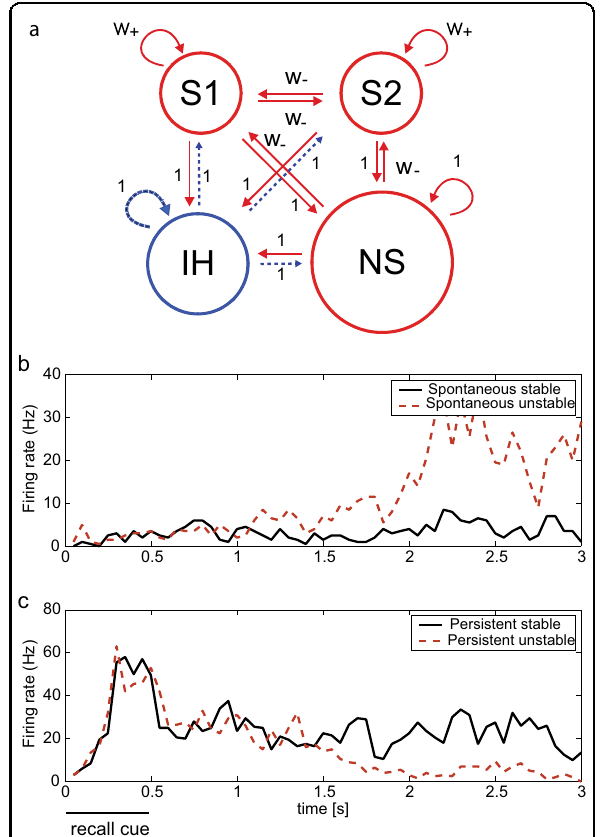
Fig. 2 Stability and Instability in Attractor Networks. a The attractor network model. The excitatory neurons (red) are divided into two selective pools S1 and S2 (with 40 neurons each) with strong intra-pool connection strengths w + and one non-selective pool (NS) (with 320 neurons). The other connection strengths are 1 or weak w − . The network contains 500 neurons, of which 400 are in the excitatory pools and 100 are in the inhibitory pool IH (blue). Each neuron in the network also receives inputs from 800 external neurons, and these neurons increase their fi ring rates to apply a stimulus or distractor to one of the pools S1 or S2. The synaptic connection matrices are provided elsewhere 4,7,29 . b Example trials of the integrate-and- fi re attractor network simulations of short-term memory. The average fi ring rate of all the neurons in the S1 neuronal population (or pool) is shown. Performance without a recall cue. The spontaneous fi ring rate is maintained at a low rate correctly on most trials (spontaneous stable), but on some trial the spiking-related noise in the network triggers the S1 population of neurons into a high fi ring rate state (spontaneous unstable), which is incorrect. c Performance with a recall cue applied to S1 at 0 – 500 ms. In the stable persistent (i.e., short-term memory) type of trial, the fi ring continues or persists at a moderate rate throughout the trial after the end of the recall cue (persistent stable), and this is correct. On some trials, the spiking-related noise provokes a transition to the low fi ring rate state, and this is incorrect (persistent unstable). In these simulations, the network parameter was w + = 2.1. (Modi fi ed from Loh et al. 7 ).